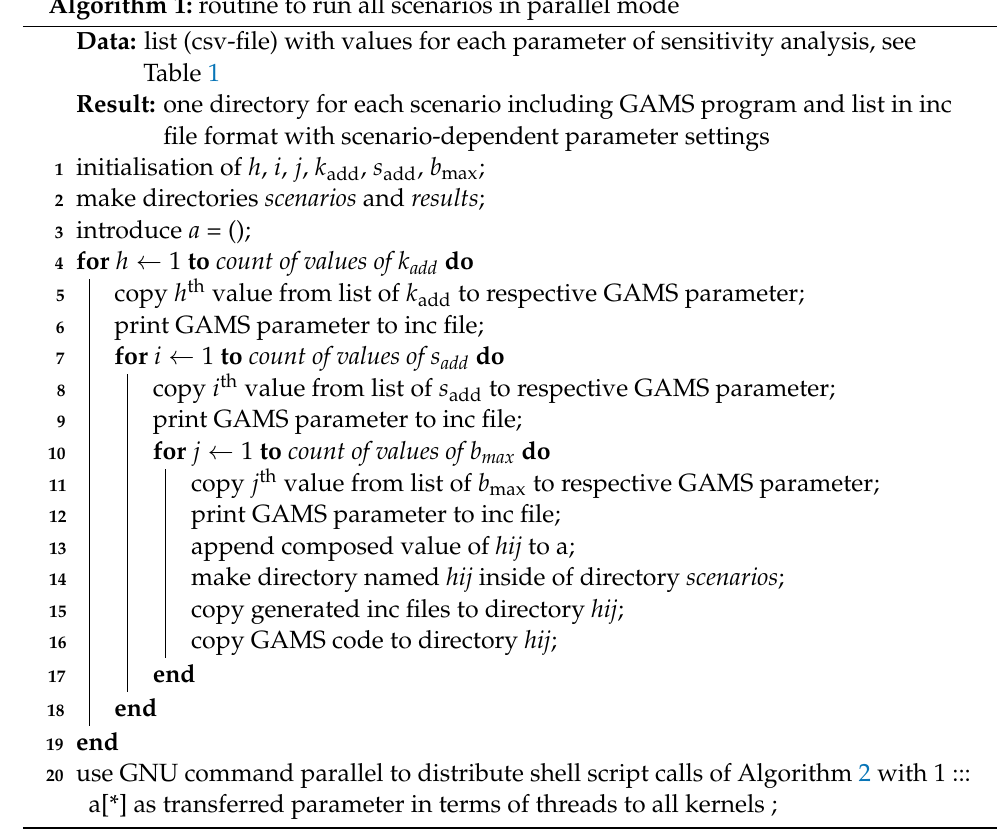
Algorithm 1: routine to run all scenarios in parallel mode